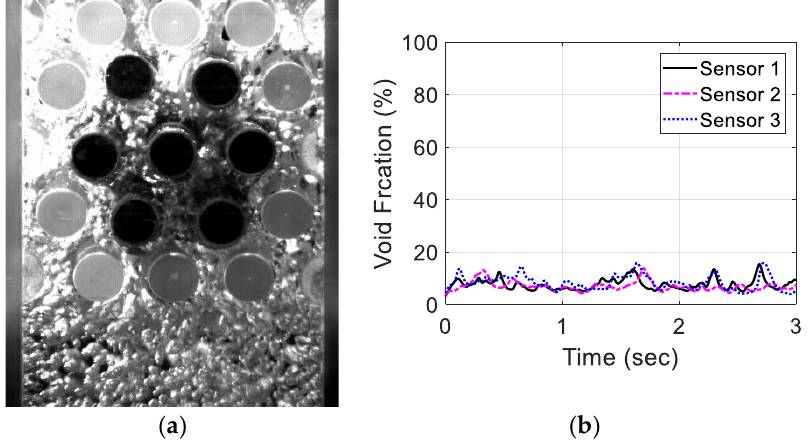
Figure 23. Experimental results for an air flow rate of 5 L/min for the three-sensor configuration: ( a ) flow visualization and ( b ) void fraction signal.